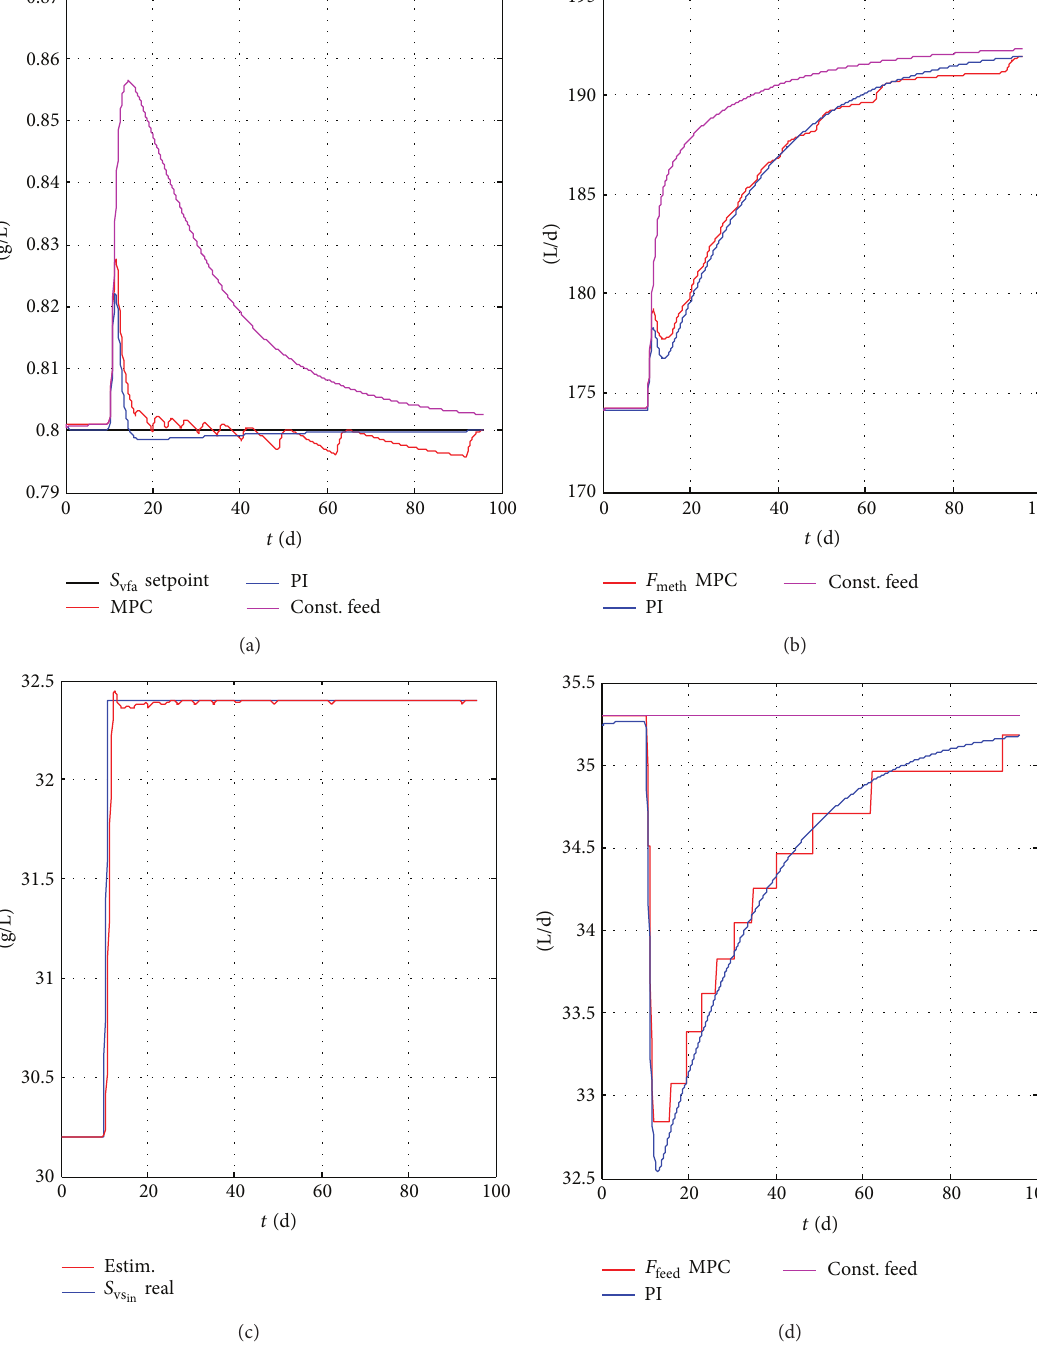
, predictive control (MPC), and PI control. Simulated responses in feed